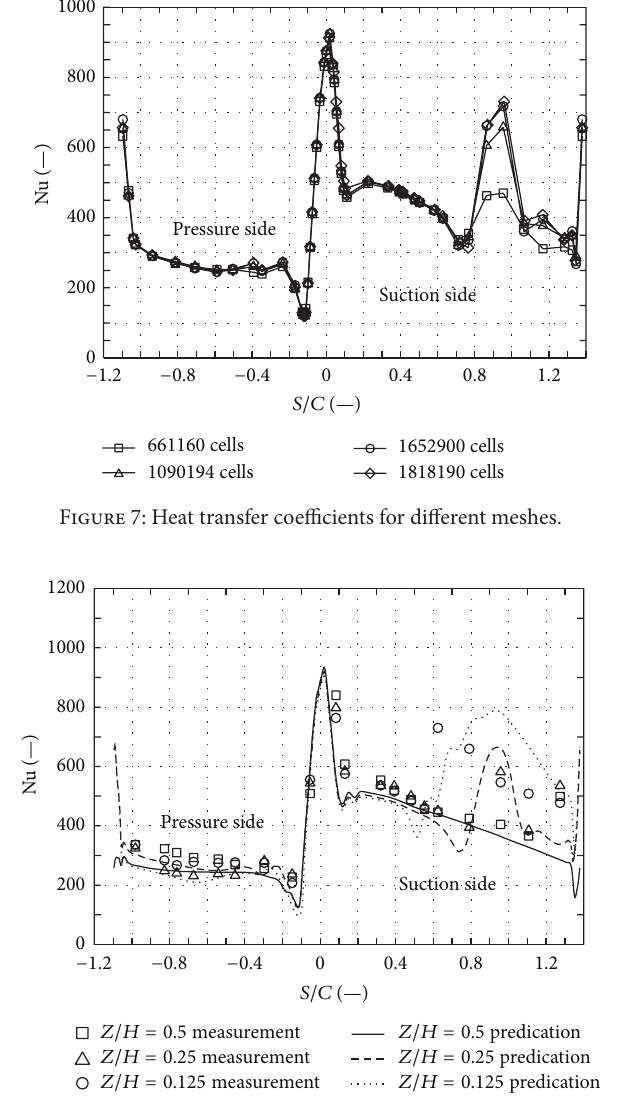
Figure 8: Nusselt number distribution on the blade surface at different spanwise locations, Re = 106000.